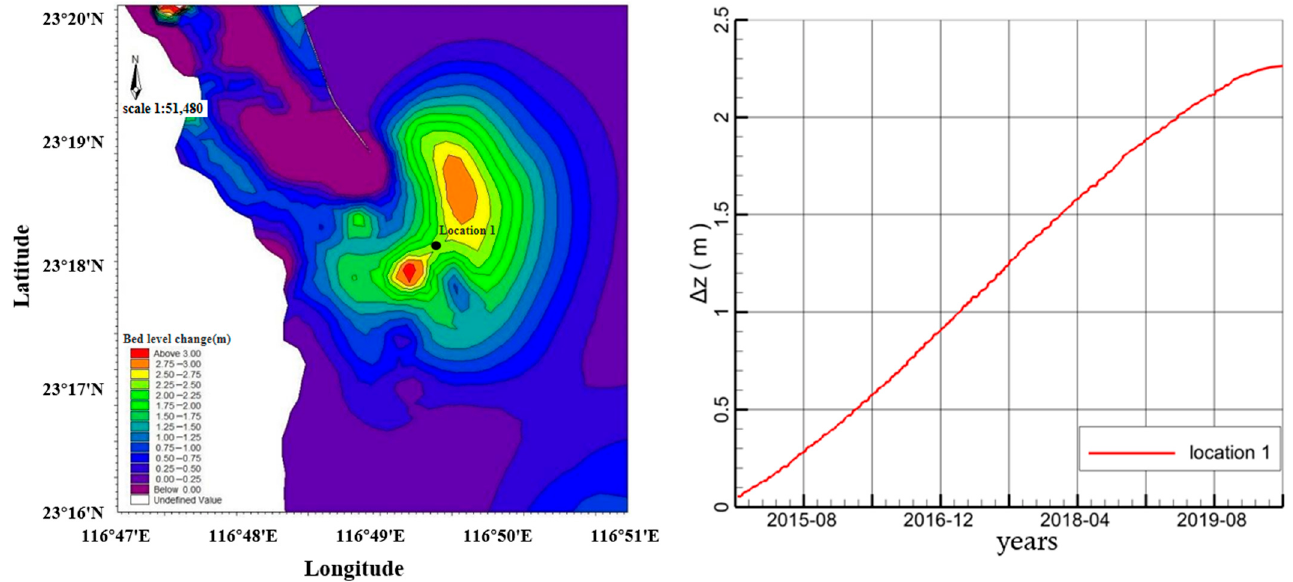
Figure 16. Changes of sedimentation thickness in Rongjiang Estuary in 5 years.